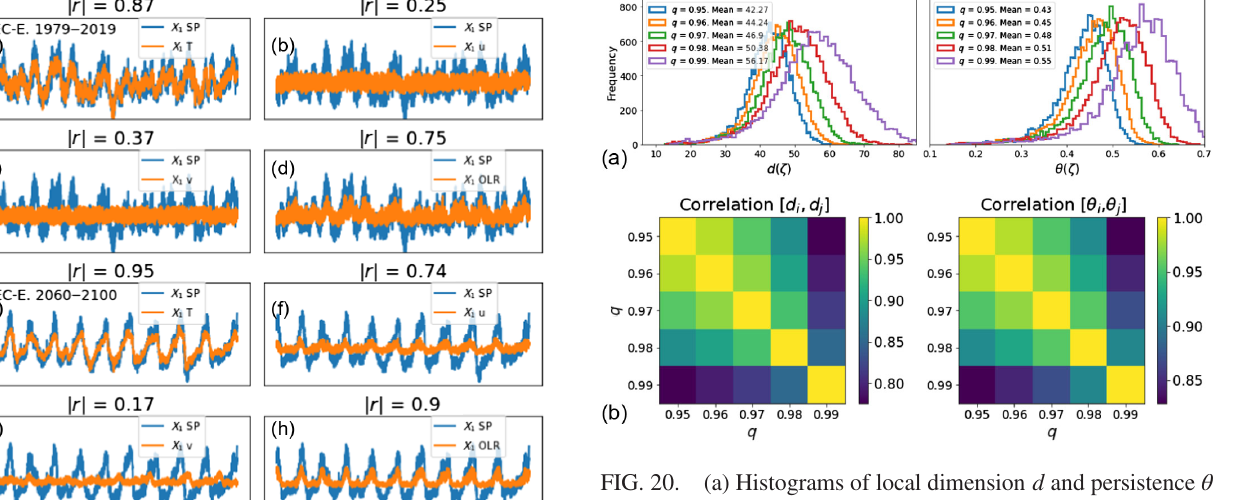
FIG. 20. (a) Histograms of local dimension d and persistence θ identified using different q . (b) Pairwise correlation matrix of d and θ identified using different q . The analysis is performed on the multivariate state space